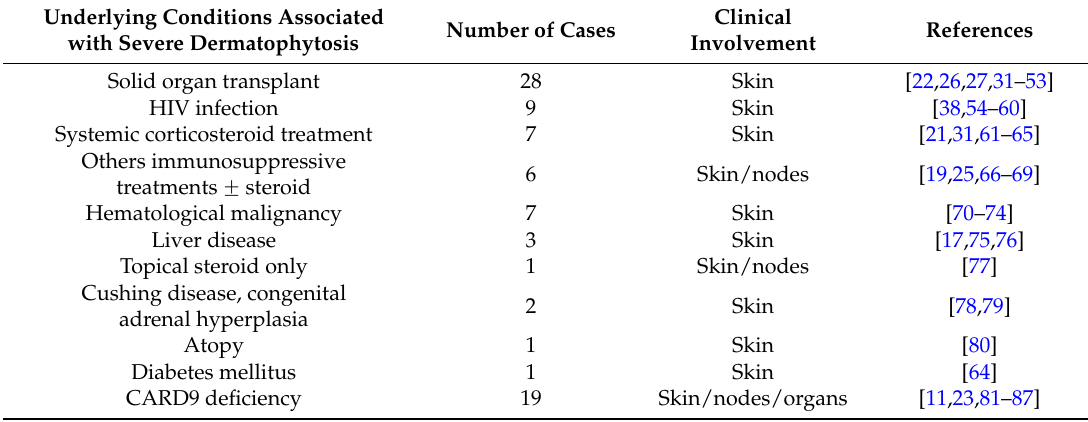
Table 1. Underlying conditions associated with severe dermatophytosis, a review of the